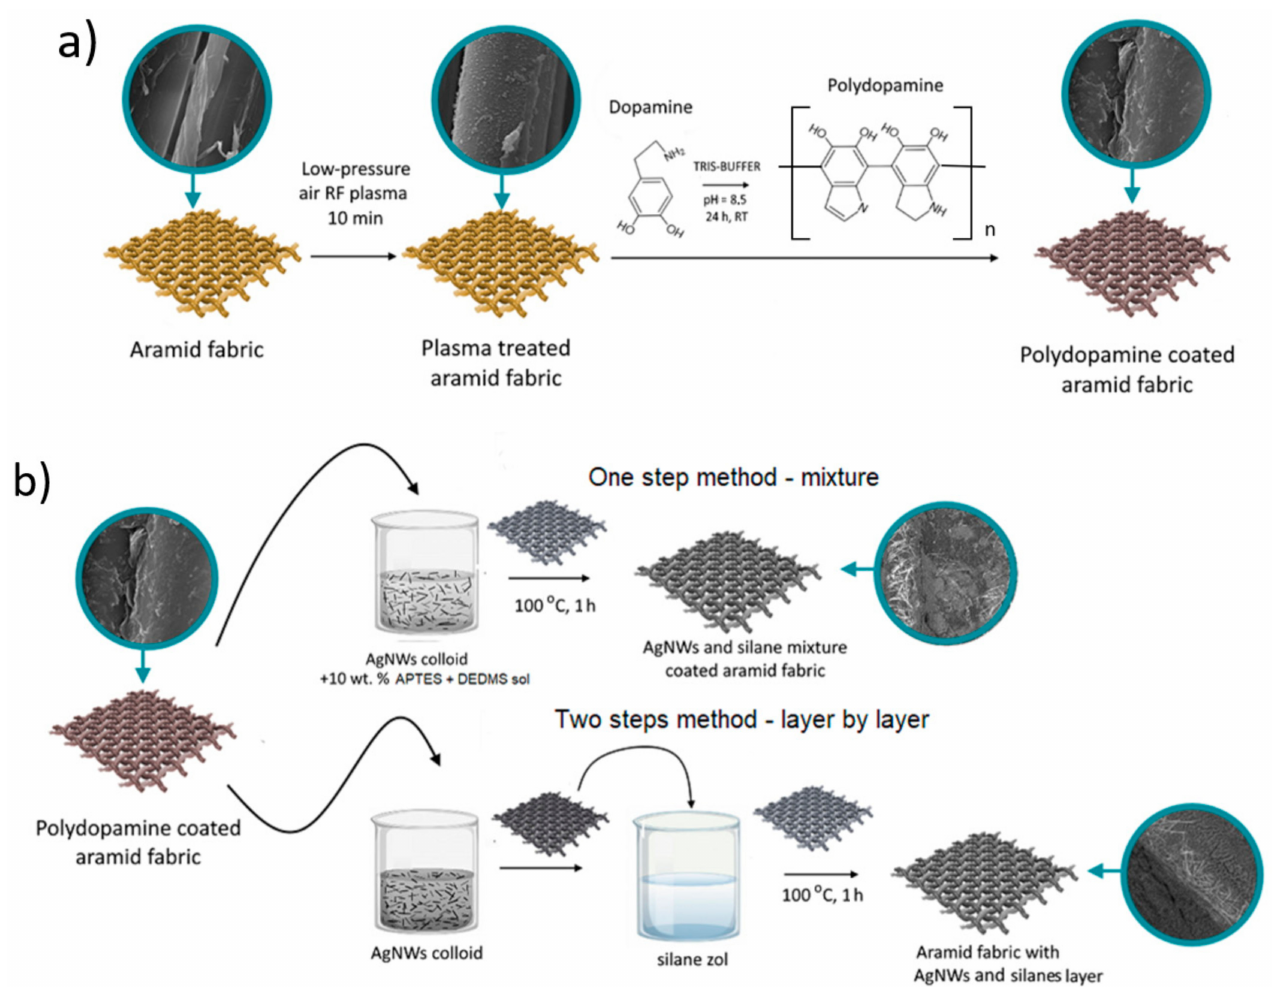
Figure 1. The scheme of the modification of aramid fabrics with ( a ) low-pressure air RF plasma and polydopamine and ( b ) the application of AgNWs and silanes by the mixture and layer-by-layer method. Silanes Sol